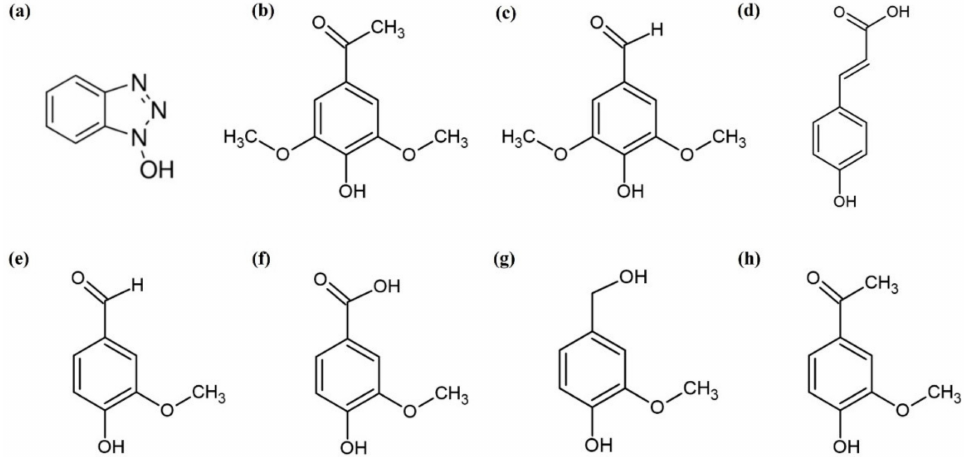
Figure 2. The structure of mediators used for LMS. ( a ) HOBt, ( b ) acetosyringone, ( c ) syringaldehyde, ( d ) p -coumaric acid, ( e ) vanillin, ( f ) vanillic acid, ( g ) vanillyl alcohol, ( h )